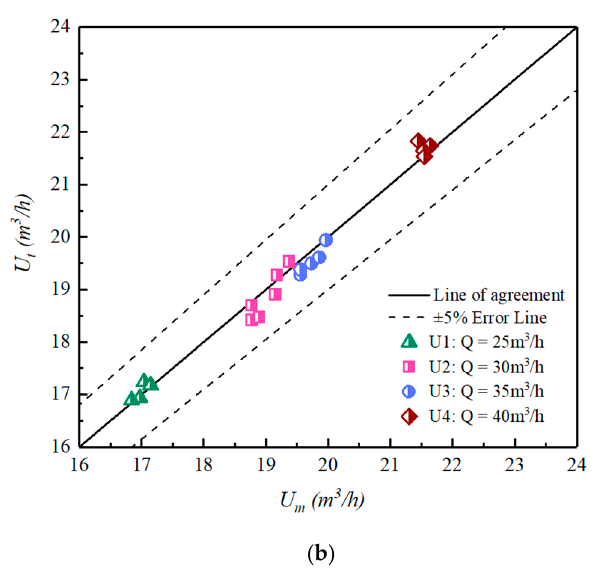
Figure 6. Comparison of measured and theoretical mean velocities: ( a ) T1–T3; ( b ) U1–U4.